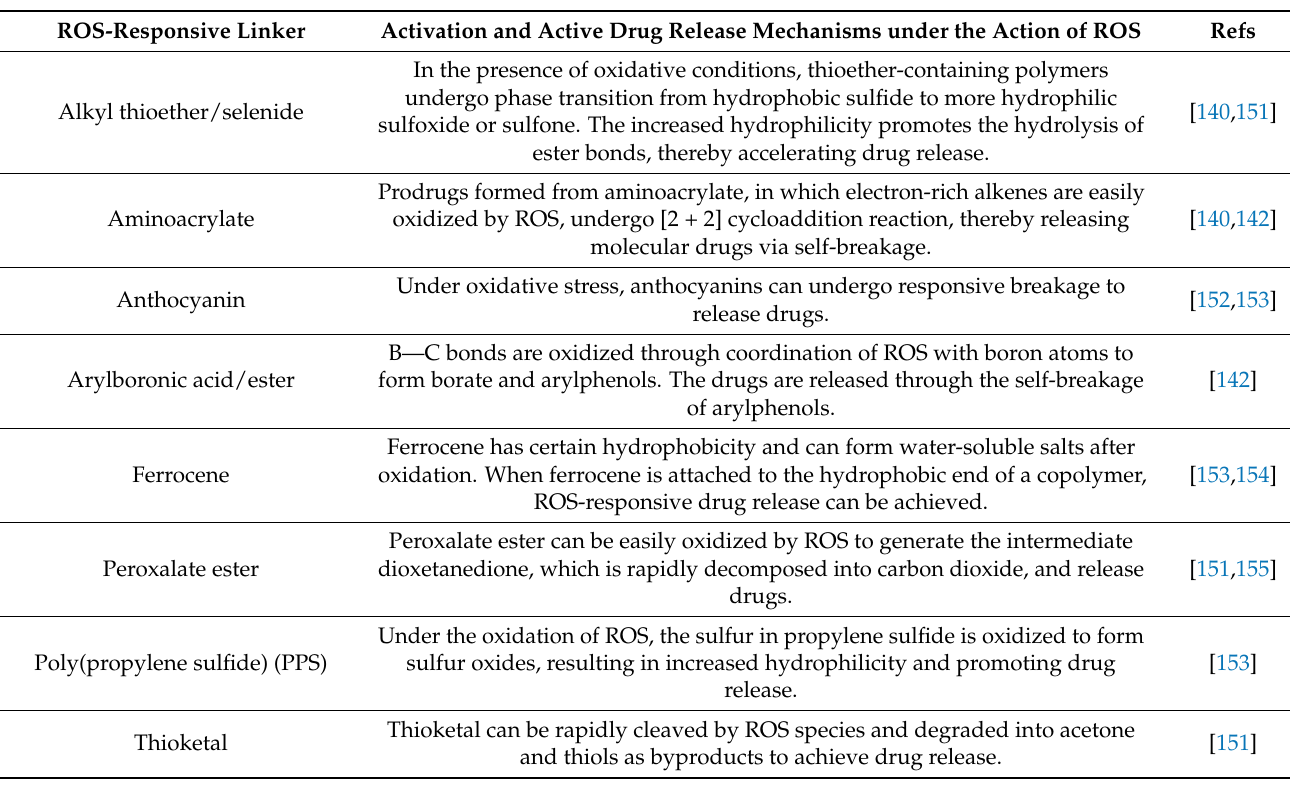
Table 2. Common ROS-responsive